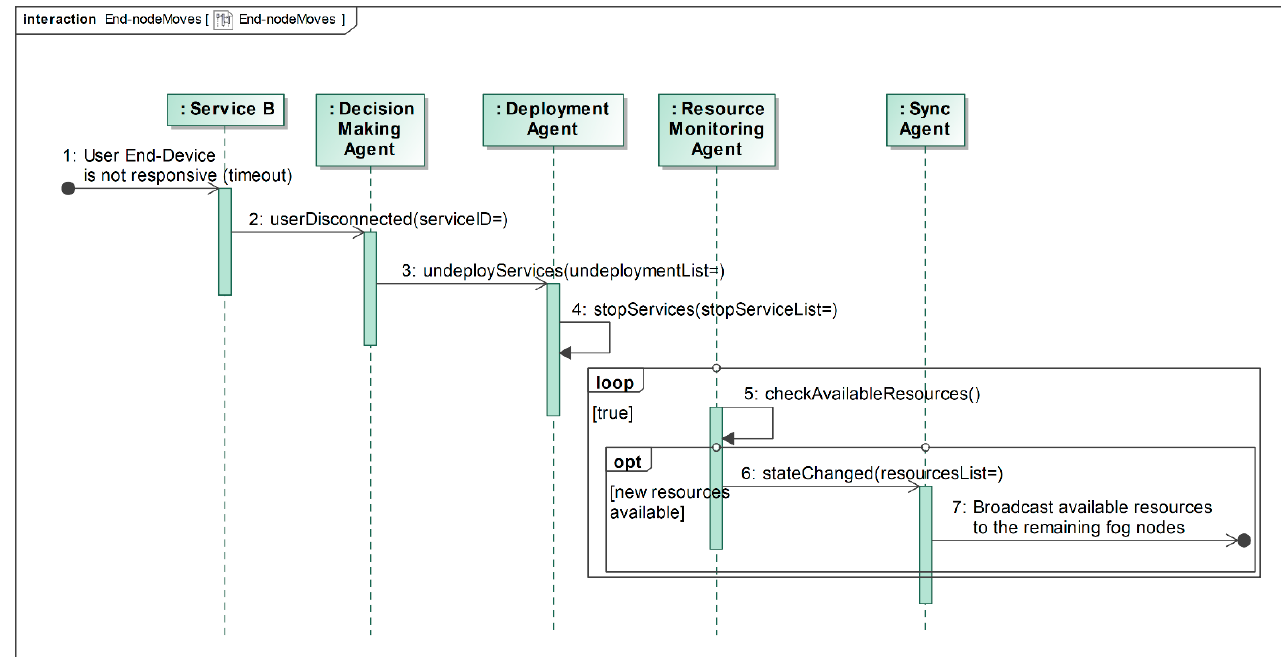
Figure 6 . Disconnection from the fog node, when the user end-device moves between fog nodes.